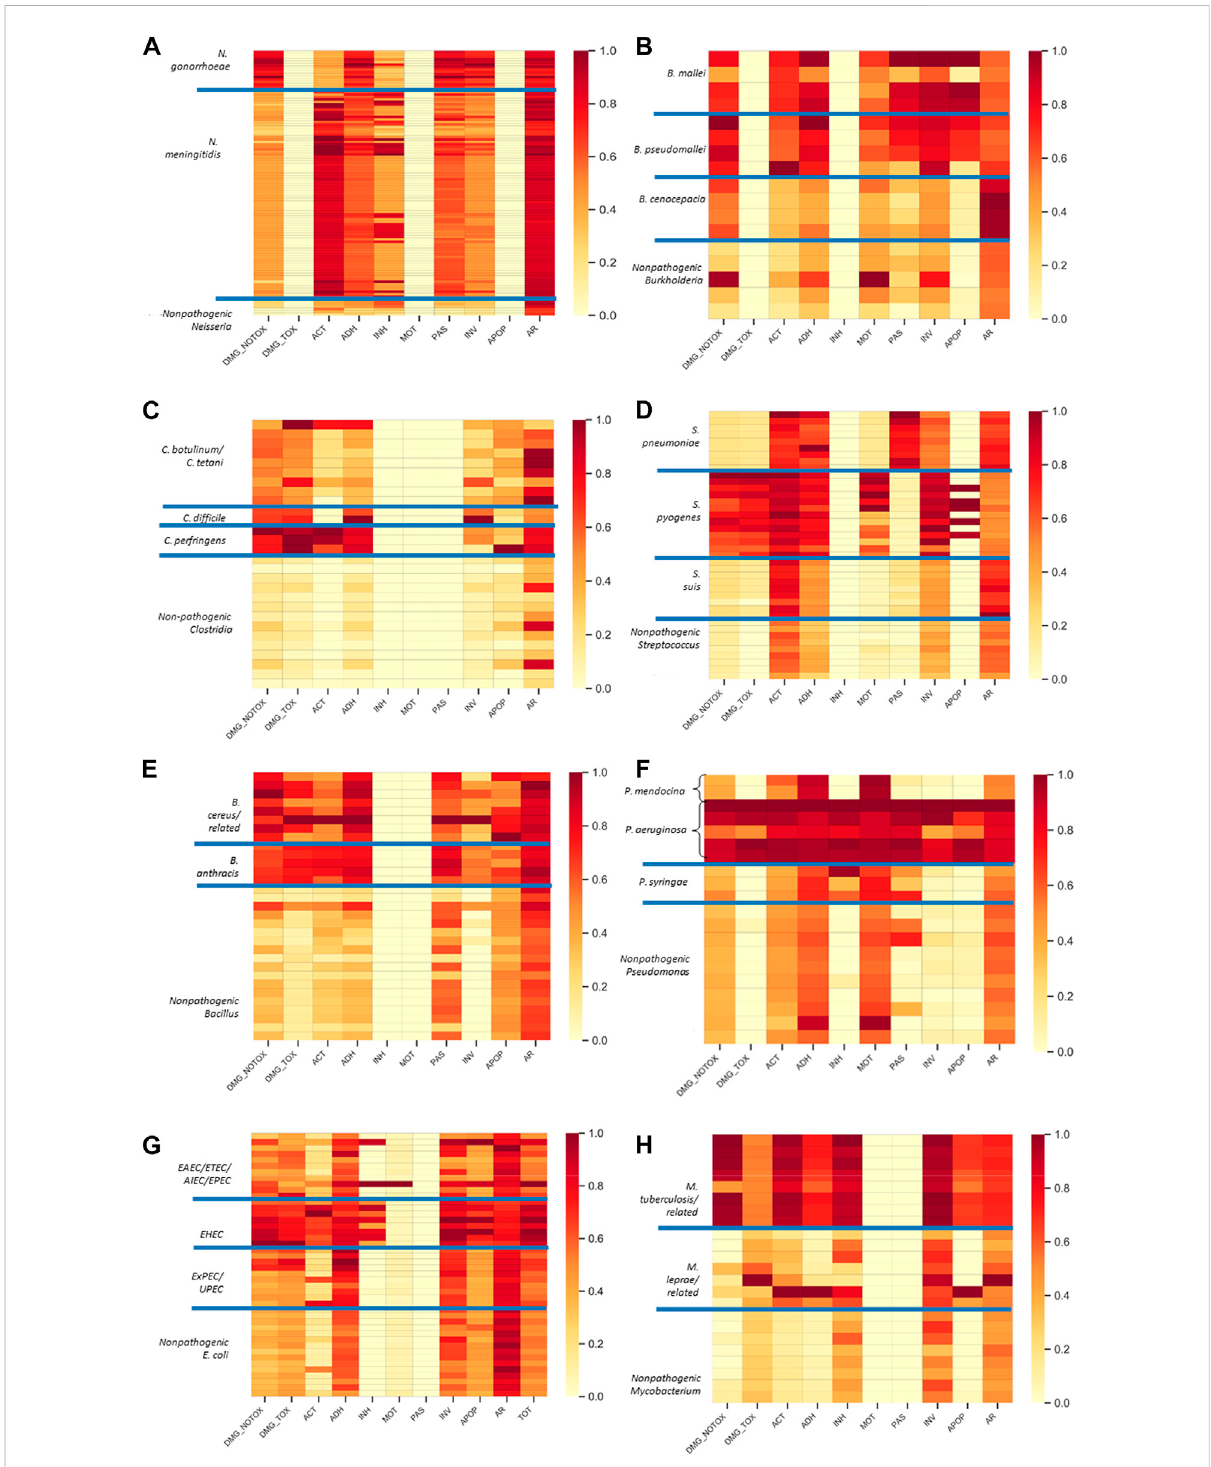
FIGURE 3 Pathogenic species are enriched in hazardous functional categories. Shown are the hazard fi ngerprints for Neisseria (A) , Burkholderia (B) , Clostridium (C) , Streptococcus (D) , Bacillus (E) , Pseudomonas (F) , E. coli (G) , and Mycobacterium (H) . The fi ngerprints are shown as rows in a heat plot with the values in each column representing the normalized fraction of CDSs within each functional category (as de fi ned in Table 1). Only the relevant categories from Table 1 are included (i.e., those that provided alignments). The pathogenic subgroups within each organism group are de fi nedinTable3andseparatedbythebluelinesontheheatplot.Abbreviations:DMG_NOTOX,damagewithouttoxinactivityGOterm,DMG_TOX, damage with toxin activity GO term; ACT, active host subversion; ADH, adherence; INH, inhibits host cell death; MOT, motility; PAS, passive